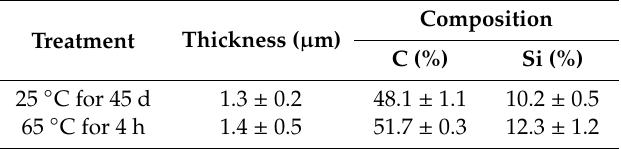
Table 3. Thickness and composition of the hybrid coatings synthesized from the [TMOS]/[MPTS] mixture.